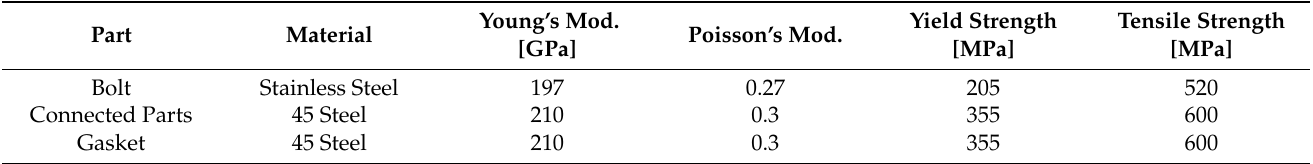
Table 2. Test Piece Material Parameters Table.